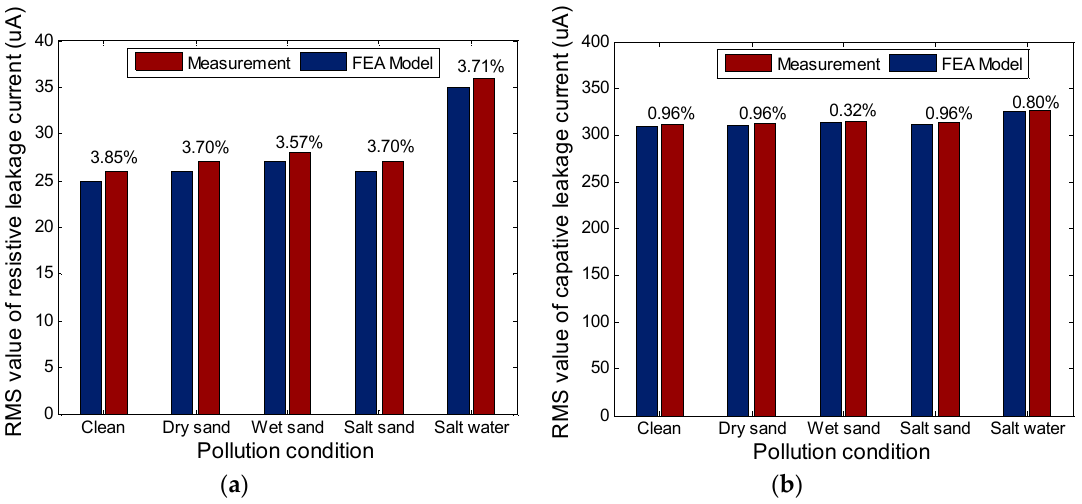
Figure 13. Comparison of RMS value of leakage current between measurement and FEA model under different artificial pollution conditions at 8 kV rms ( a ) Resistive; ( b ) Capacitive.